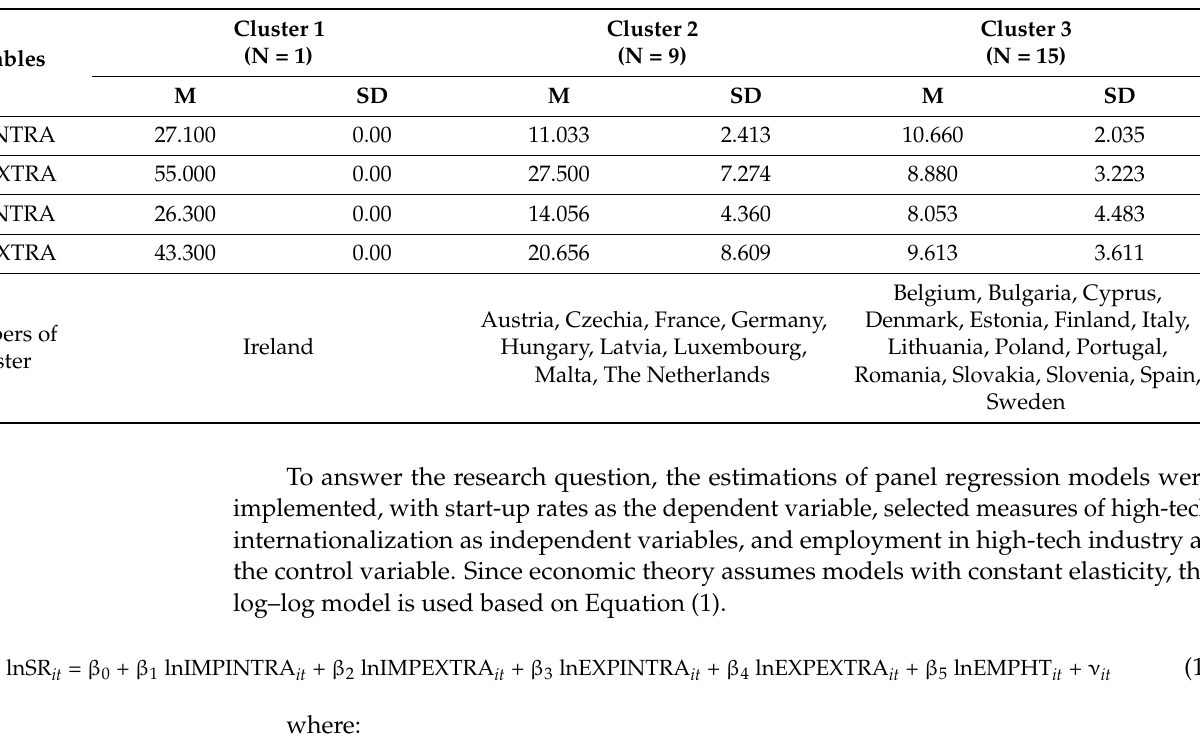
Table 3. Descriptive statistics of